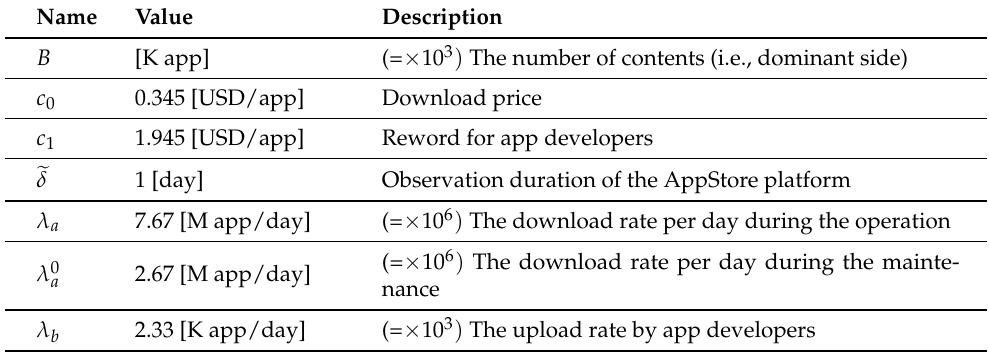
Table 3. Initial conditions of the Omnia